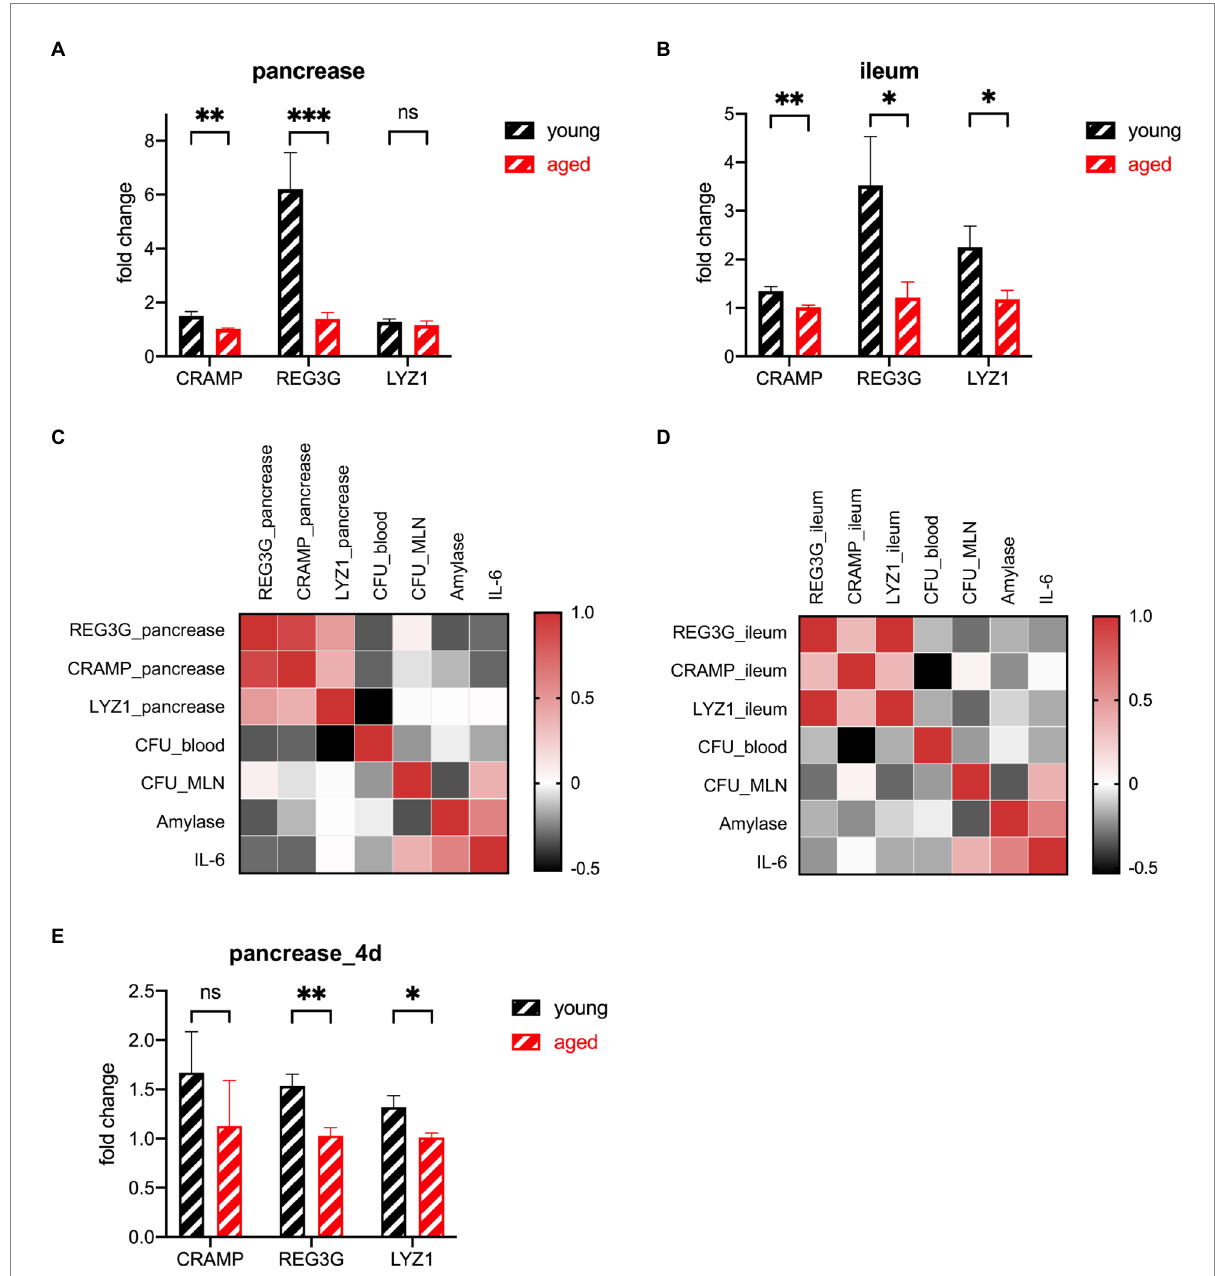
FIGURE 5 Expression of AMP genes in the pancreas (A) and ileum (B) of the young group ( n = 5) versus the old group ( n = 5) at the lethal endpoint of 24 h. (C) Heatmap of the Spearman correlation coefficients between the AMPs of the pancreas and other indicators. (D) Heatmap of the Spearman correlation coefficients between the AMPs of the ileum and other indicators. (E) Expression of AMP genes of the pancreatic tissue of the young group ( n = 5) versus the old group ( n = 5) at the lethal timepoint of 4 d. * p < 0.05, ** p < 0.01, *** p < 0.001, **** p < 0.0001, ns, no significant